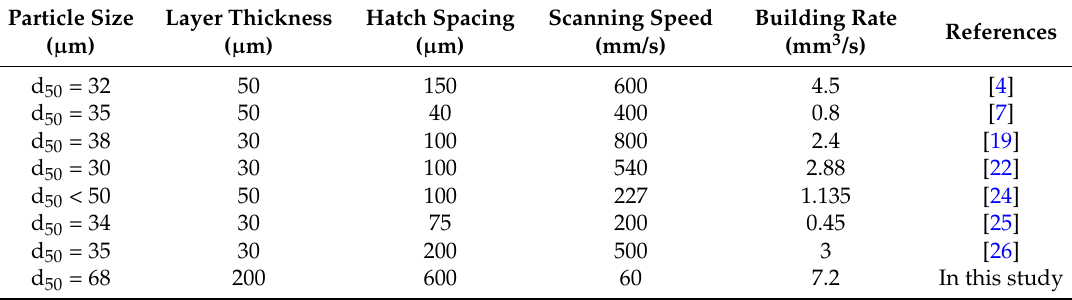
Table 2. Summary of building rates with regard to the SLM of